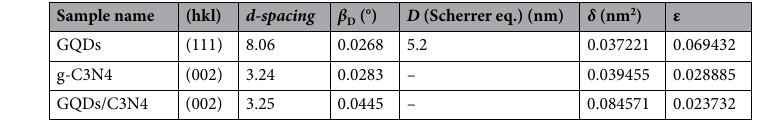
Table 2. The crystal structure parameters of GQDs, C3N4, and